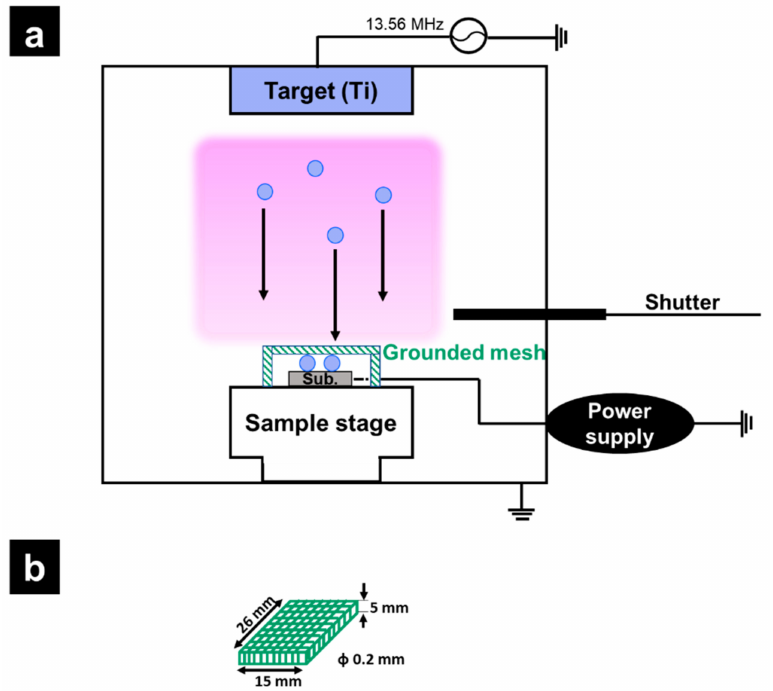
Figure 1. Schematics of system. ( a ) Radio frequency (RF) sputtering chamber. ( b ) Grounded